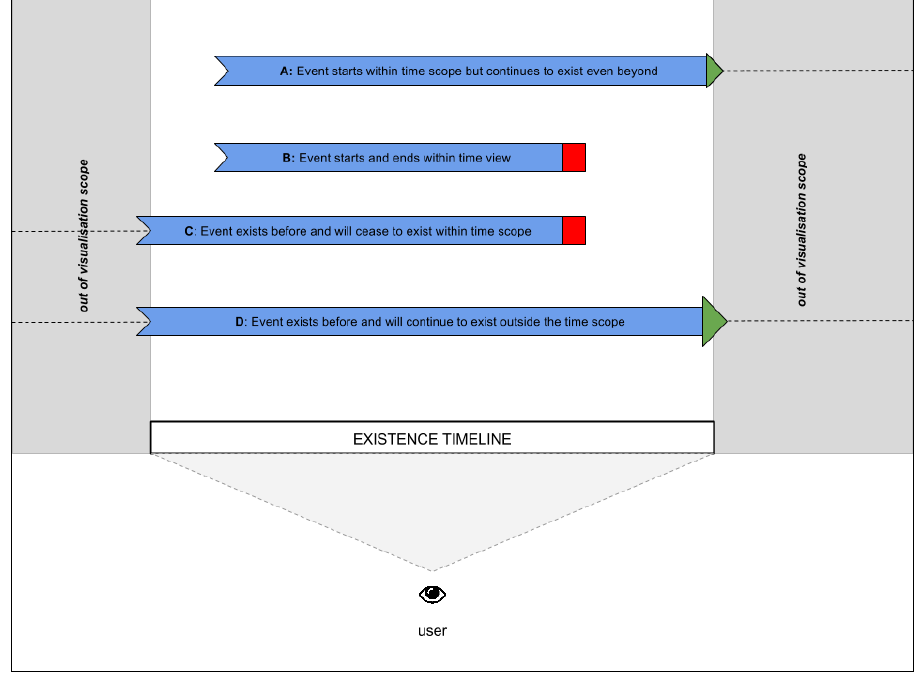
Figure 4. Existentiality timeline for geospatial objects and events